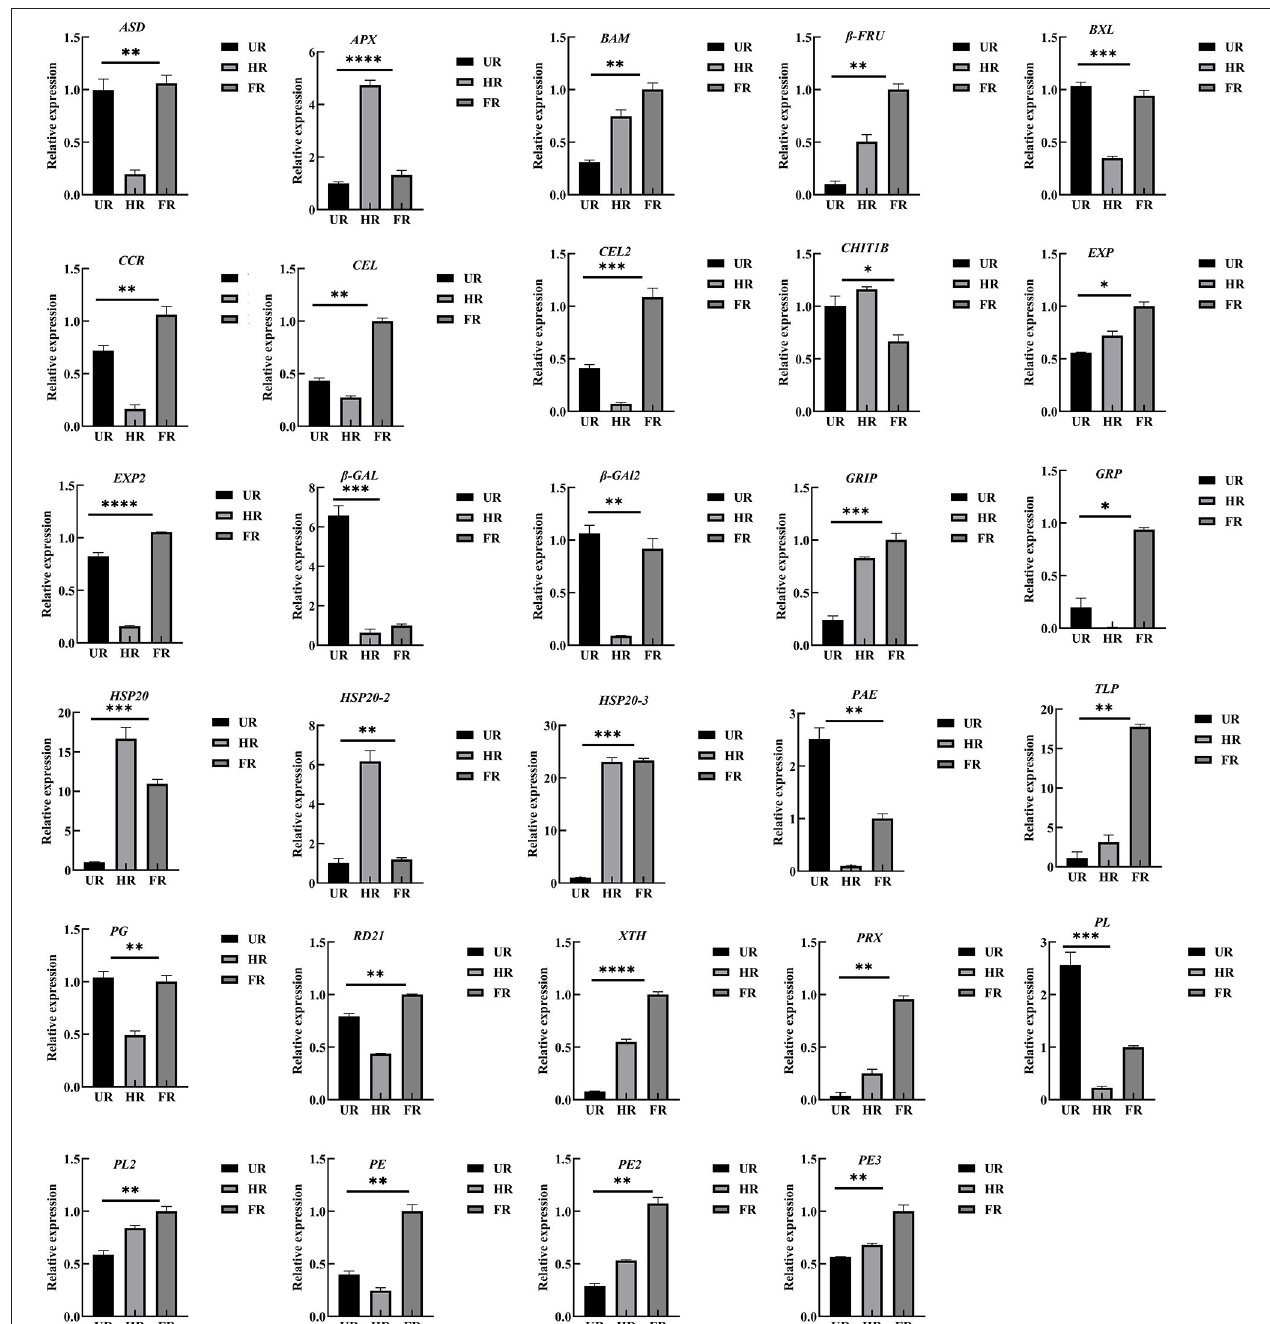
FIGURE 8 | Validation and expression analysis of selected proteins using qPCR. * p < 0.05, ** p < 0.01, *** p < 0.001, **** p <